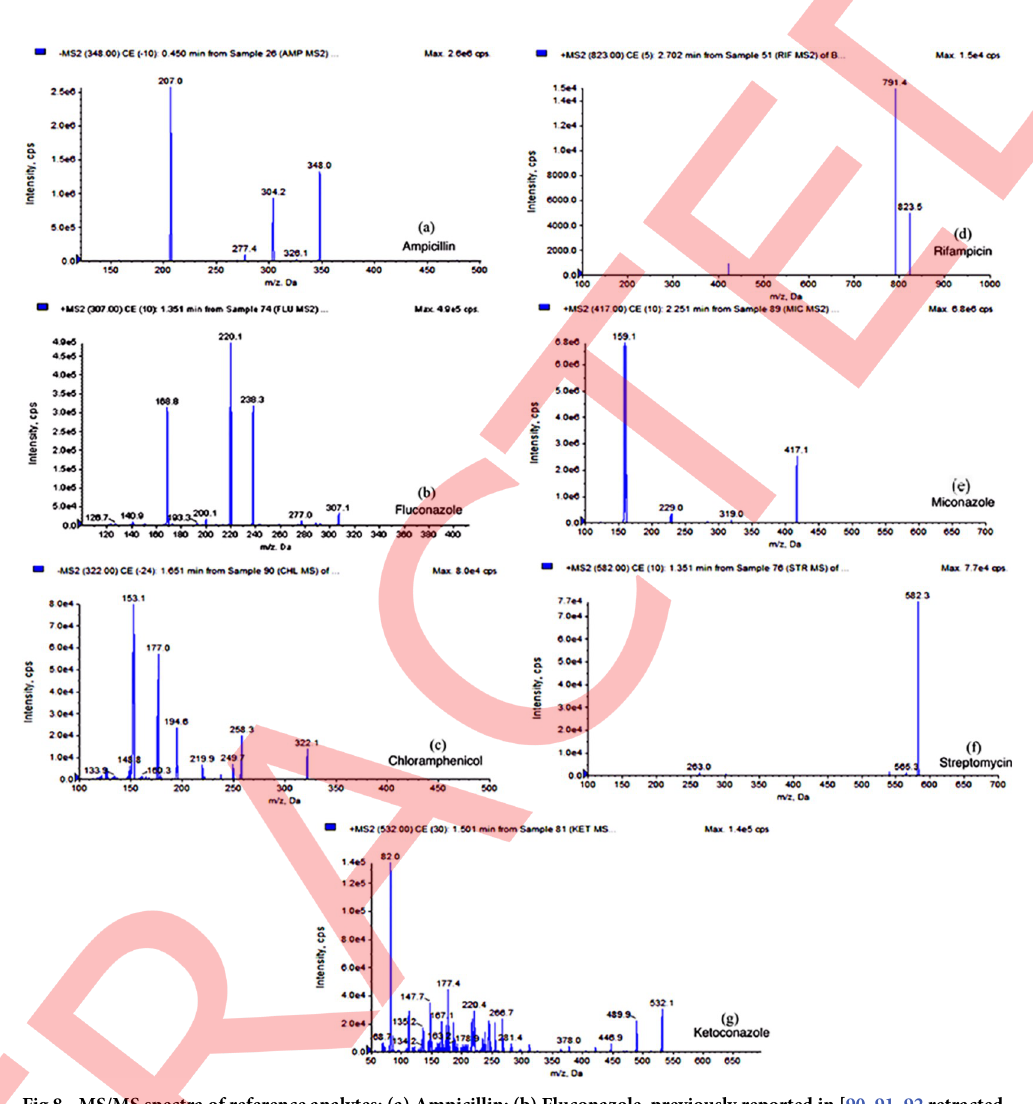
Fig 8. MS/MS spectra of reference analytes: (a) Ampicillin; (b) Fluconazole, previously reported in [90, 91, 92 retracted in 93], (c) Chlorampenicol, previously reported in [90, 91], (d) Rifampicin, previously reported in [90, 91, 92 retracted in 93], (e) Miconazole, previously reported in [91], (f) Streptomycin, previously reported in [90], and (g) Ketoconazole, previously reported in [91, 92 retracted in 93]. For Fig 8B, 8C, 8D, 8F the following copyright limitations apply: